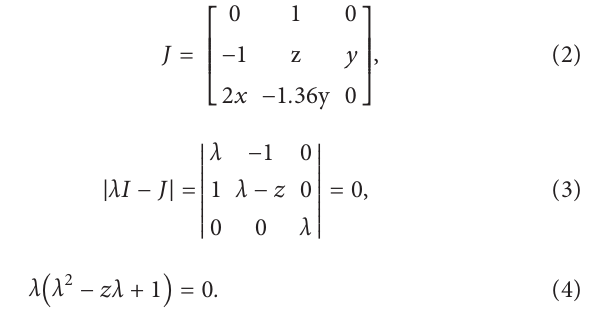
Figure 3. In positive z , the real parts of λ